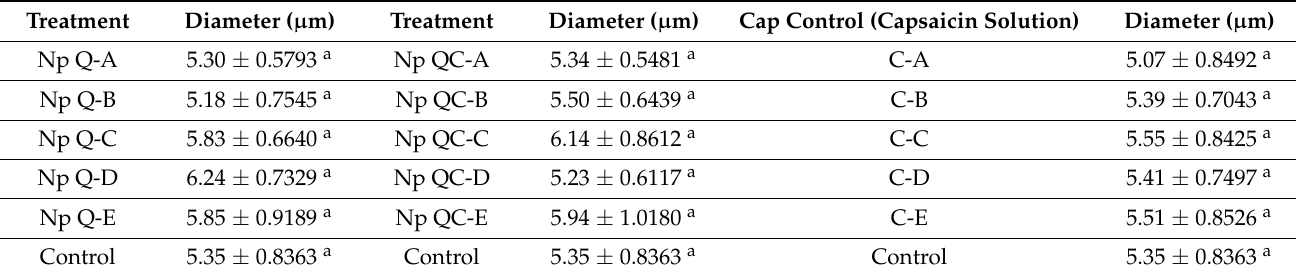
Table 4. Spore diameter of A. parasiticus exposed to Np Q and Np QC nanoparticles and capsaicin in solution. The figures indicate significant difference with respect the water control at p ≤ 0.05, according to the Tukey test.